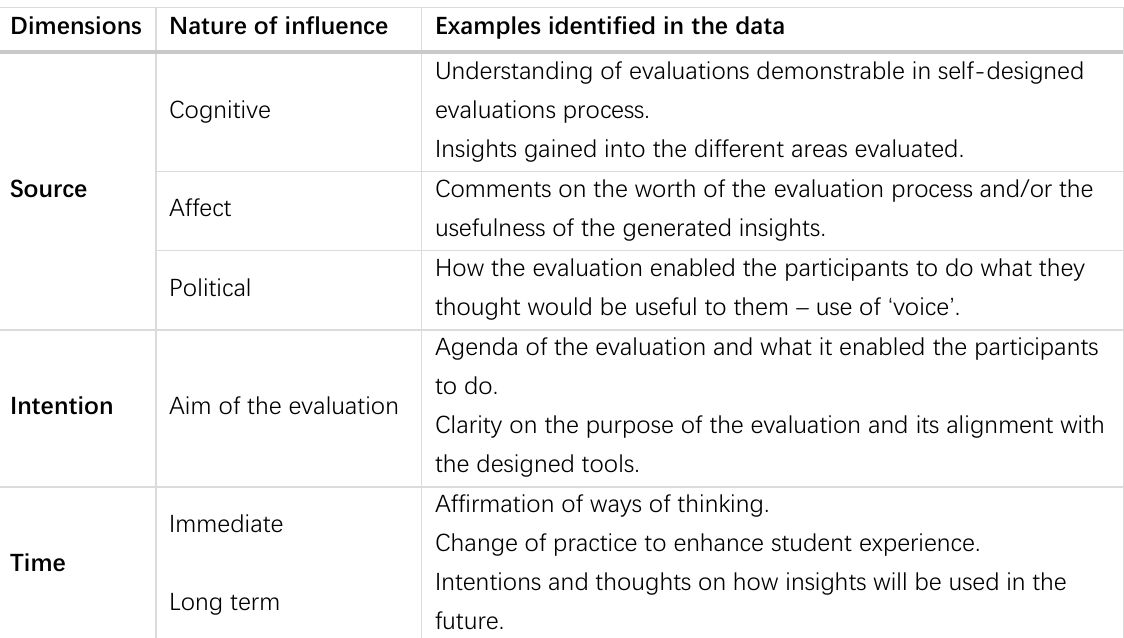
Table 3 : Examples of how the data were coded using Kirkhart’s (2000) dimensions of evaluation